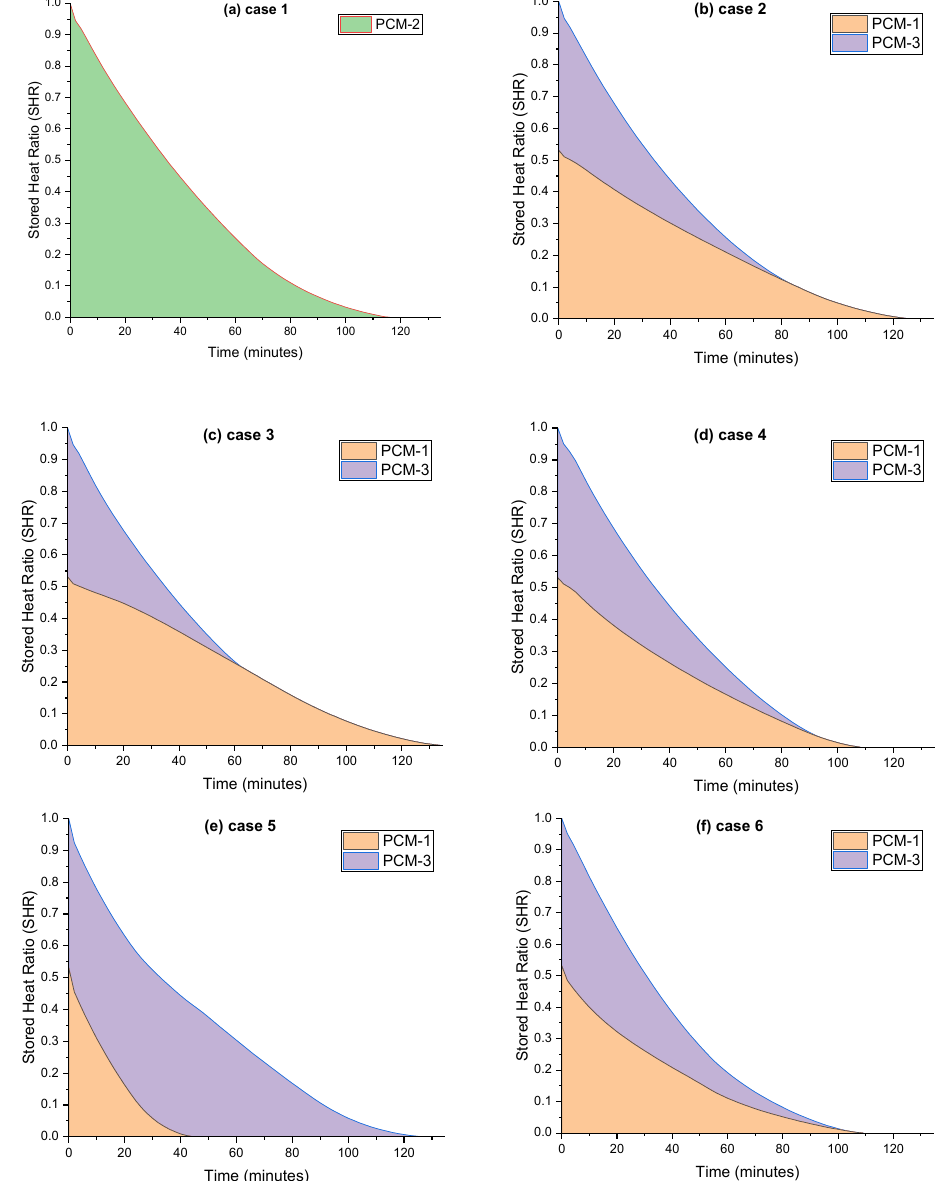
Figure 8. Transient variation of SHR for the studied cases.